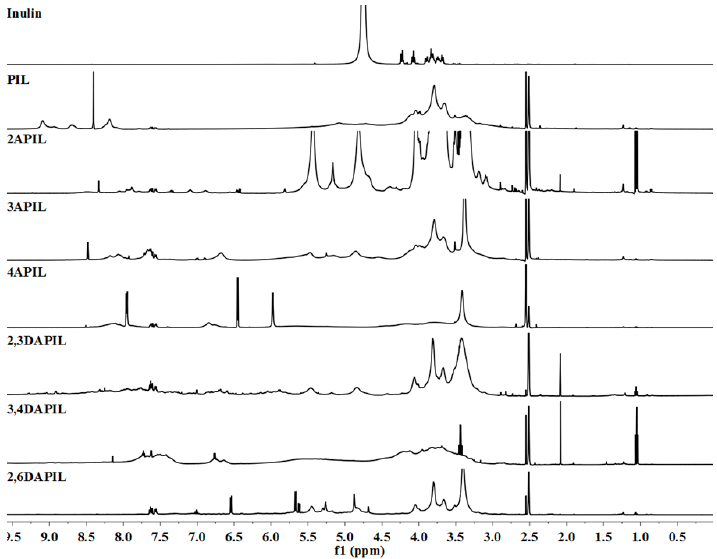
Figure 2. 1 H NMR spectra of inulin and cationic inulin derivatives.